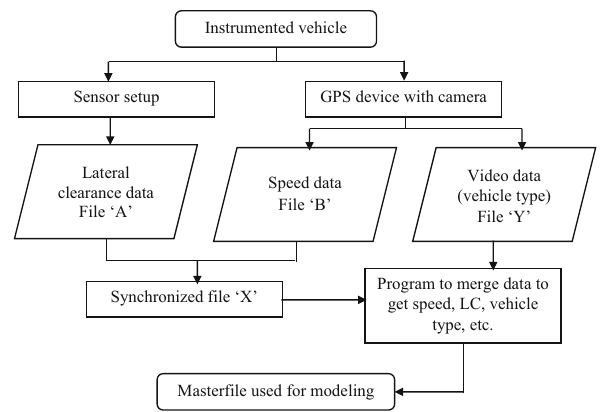
Fig. 3 Schematic diagram of file-processing for data extraction about